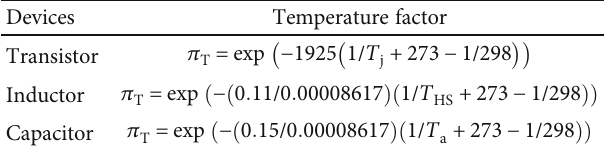
Table 2: Arrhenius model.